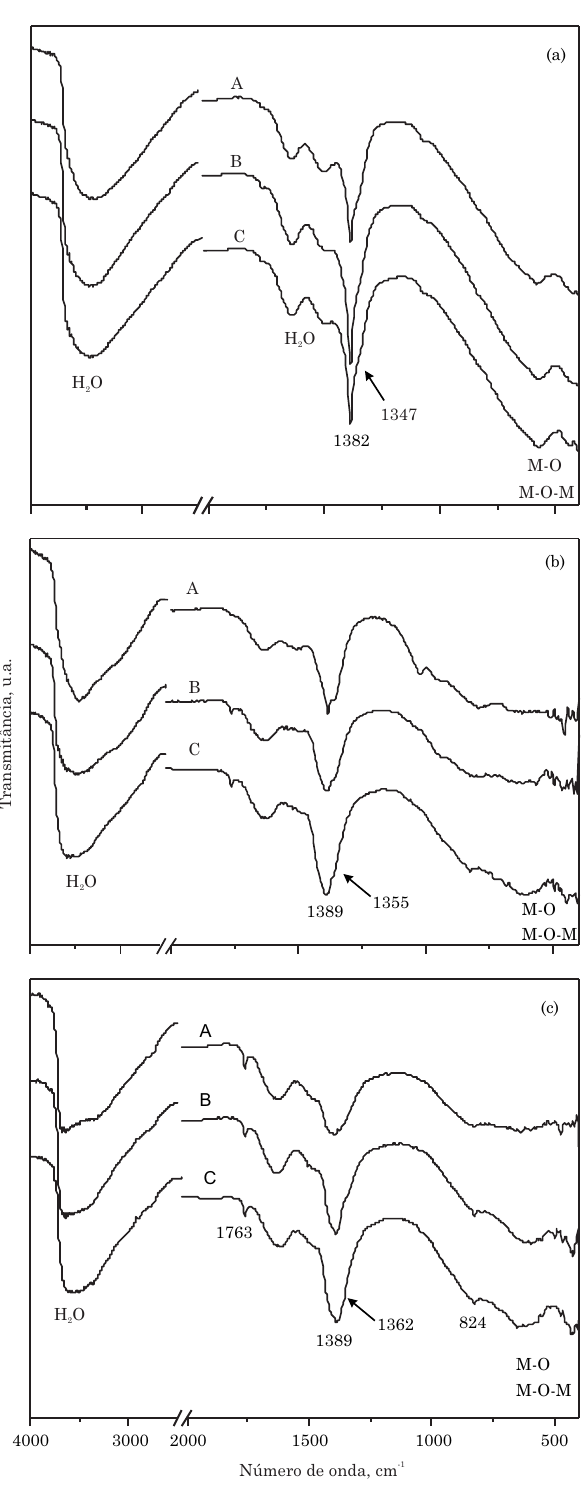
Figura 2. Espectros de FTIR dos compostos de hidróxido duplo lamelar (HDL): (a) - HDL- Mg 3 Fe 1 (A), HDL-Mg 4 Fe 1 (B) e HDL-Mg 5 Fe 1 (C) obtidos no pH 9,5; (b) - HDL-Mg 2 Al 0,5 Fe 0,5 obtido nos pHs 8 (A), 9 (B) e 10 (C); e (c) - HDL-Mg 3 Al 1 (A), HDL-Mg 4 Al 1 (B) e HDL-Mg 5 Al 1 (C) obtido no pH